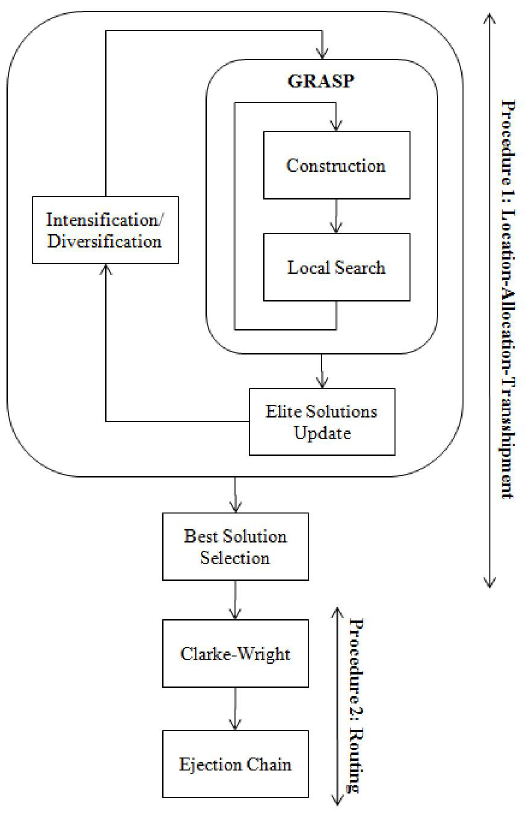
Fig. 2. The heuristic